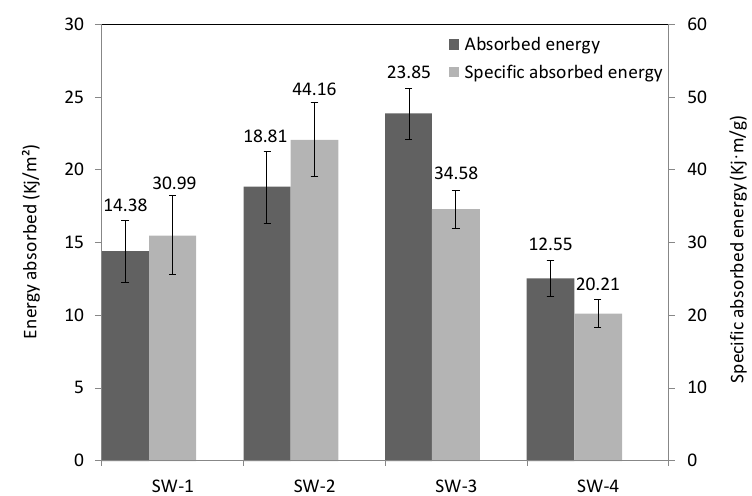
Figure 7. Impact energy absorbed during the Charpy test.